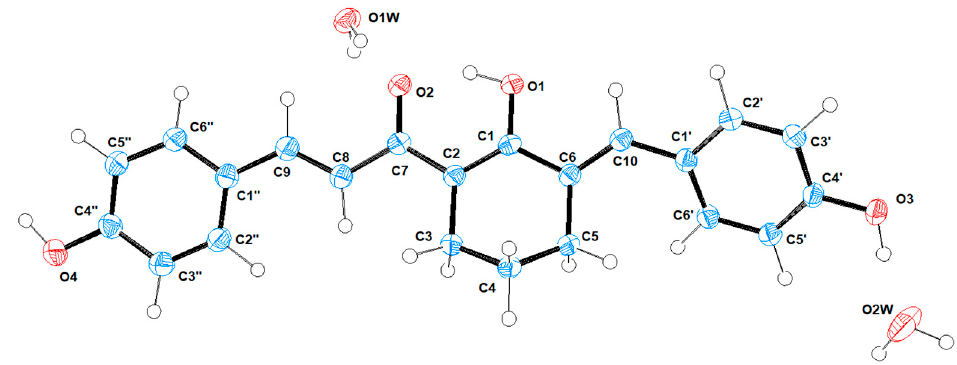
Figure 2. Oak-Ridge Thermal Ellipsoid Plot (ORTEP) of the Independent Atomic Model (IAM) of compound 1 , which crystalised from aq. ethanol in the enol form 1 ′ . Data collected at 150K, monoclinic (P2 1 /n), goodness-of-fit on F 2 = 1.078, R 1 % = 0.0393. Solved using intrinsic phasing, (SHELX-T), refined using Least Squares (SHELX-L) [16]. For full crystallographic details see ESI.